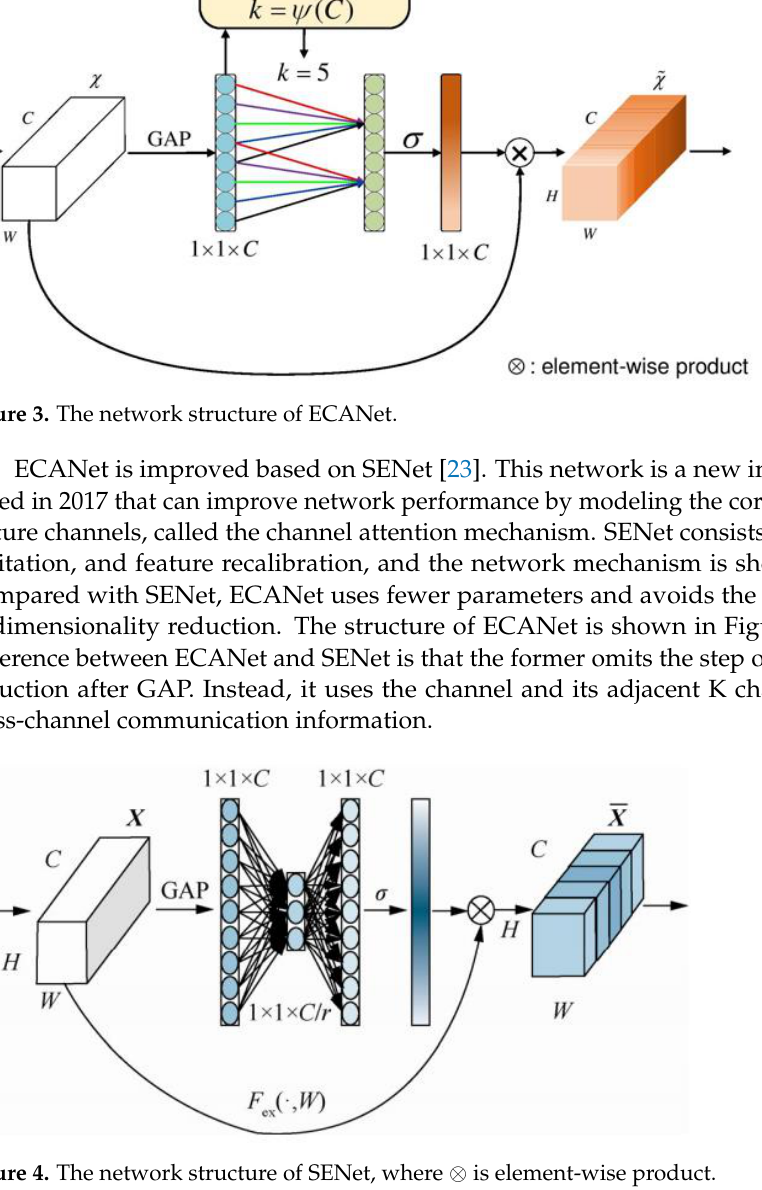
Figure 4. The network structure of SENet, where is element-wise product.